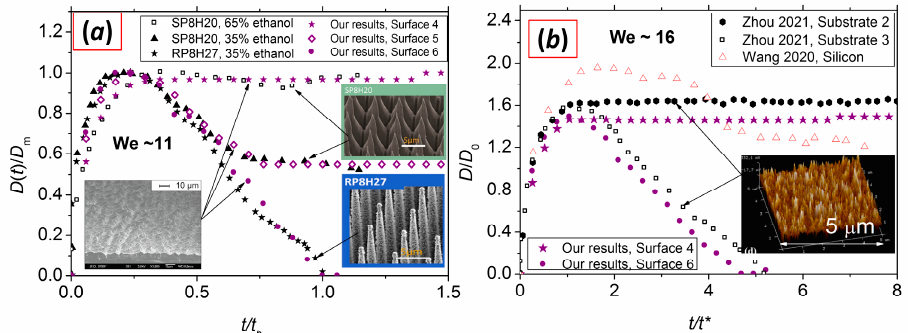
Figure 9. ( a ) Comparison with data of Ding et al. [47] for We = 11; the abscissa axis is normalized to the rebound moment t b , the ordinate axis is normalized to the maximum spreading distance; ( b ) Comparison of our results for We = 15 with those of Zhou et al. [74] for We = 17.7 and Wang et al. [32] for We = 17 . The insets show the microstructure of our surface and the surfaces from [32] and